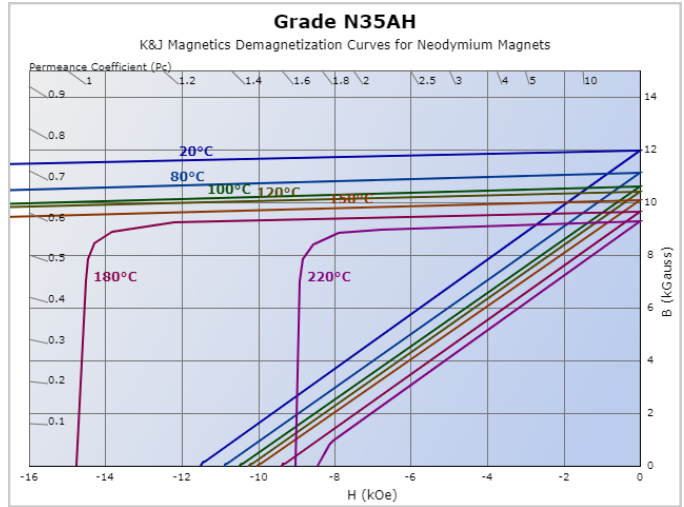
Figure A1. Demagnetization curves of NdFeB (Neomax-35AH).